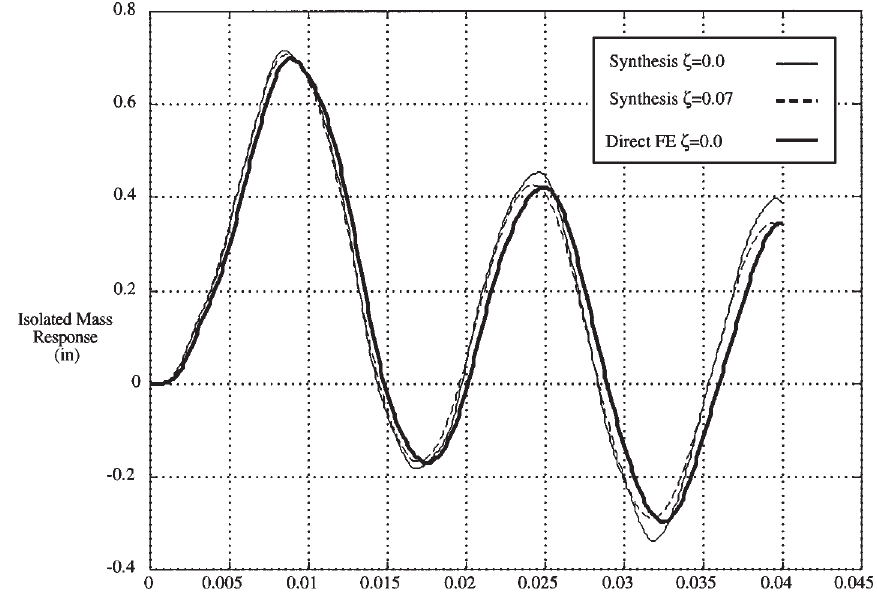
Fig. 9. Comparison of synthesis ( (cid:16) = 0 : 0,0 : 07) with Direct FE: Isolated mass vertical response vs